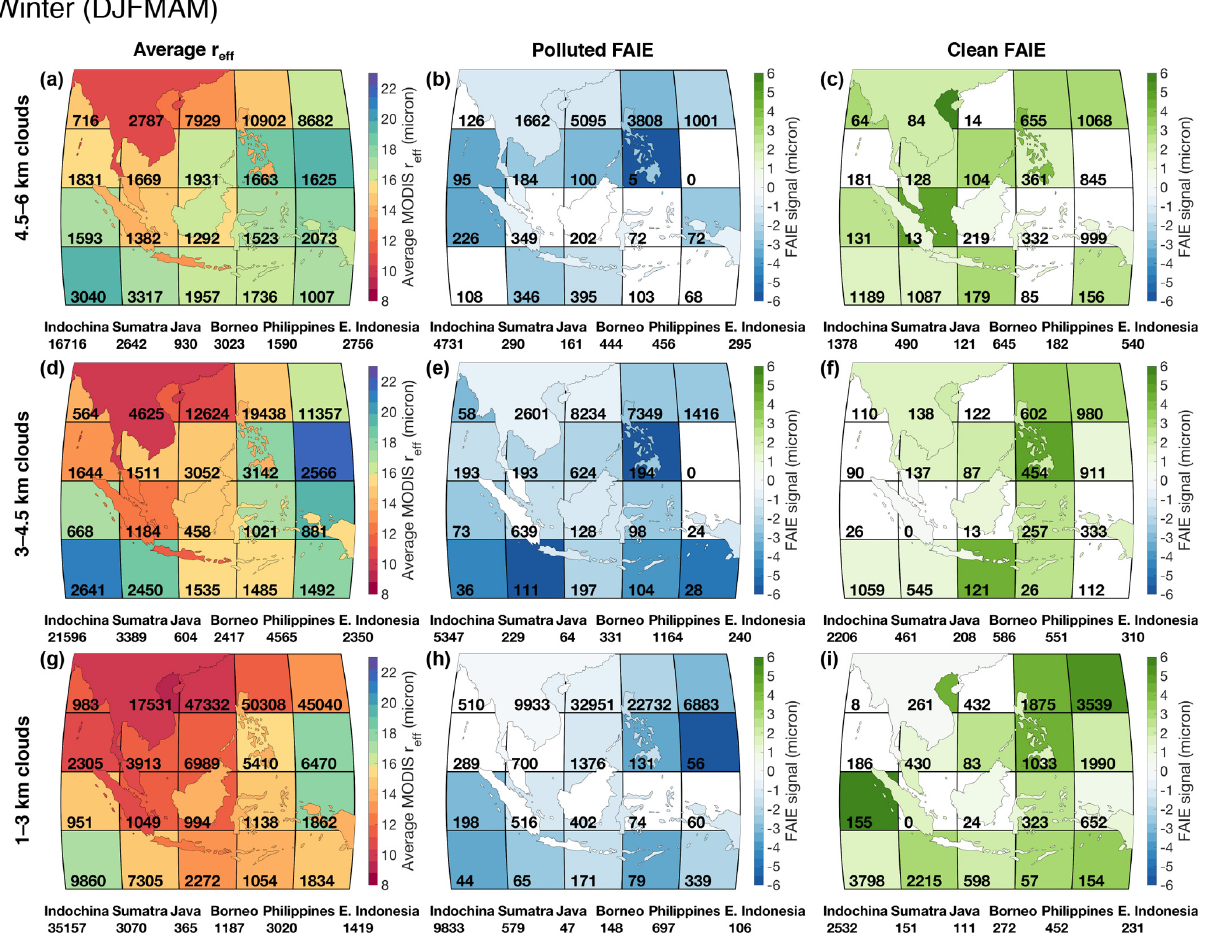
Figure 10. Identical to Fig. 9 but for winter months December through